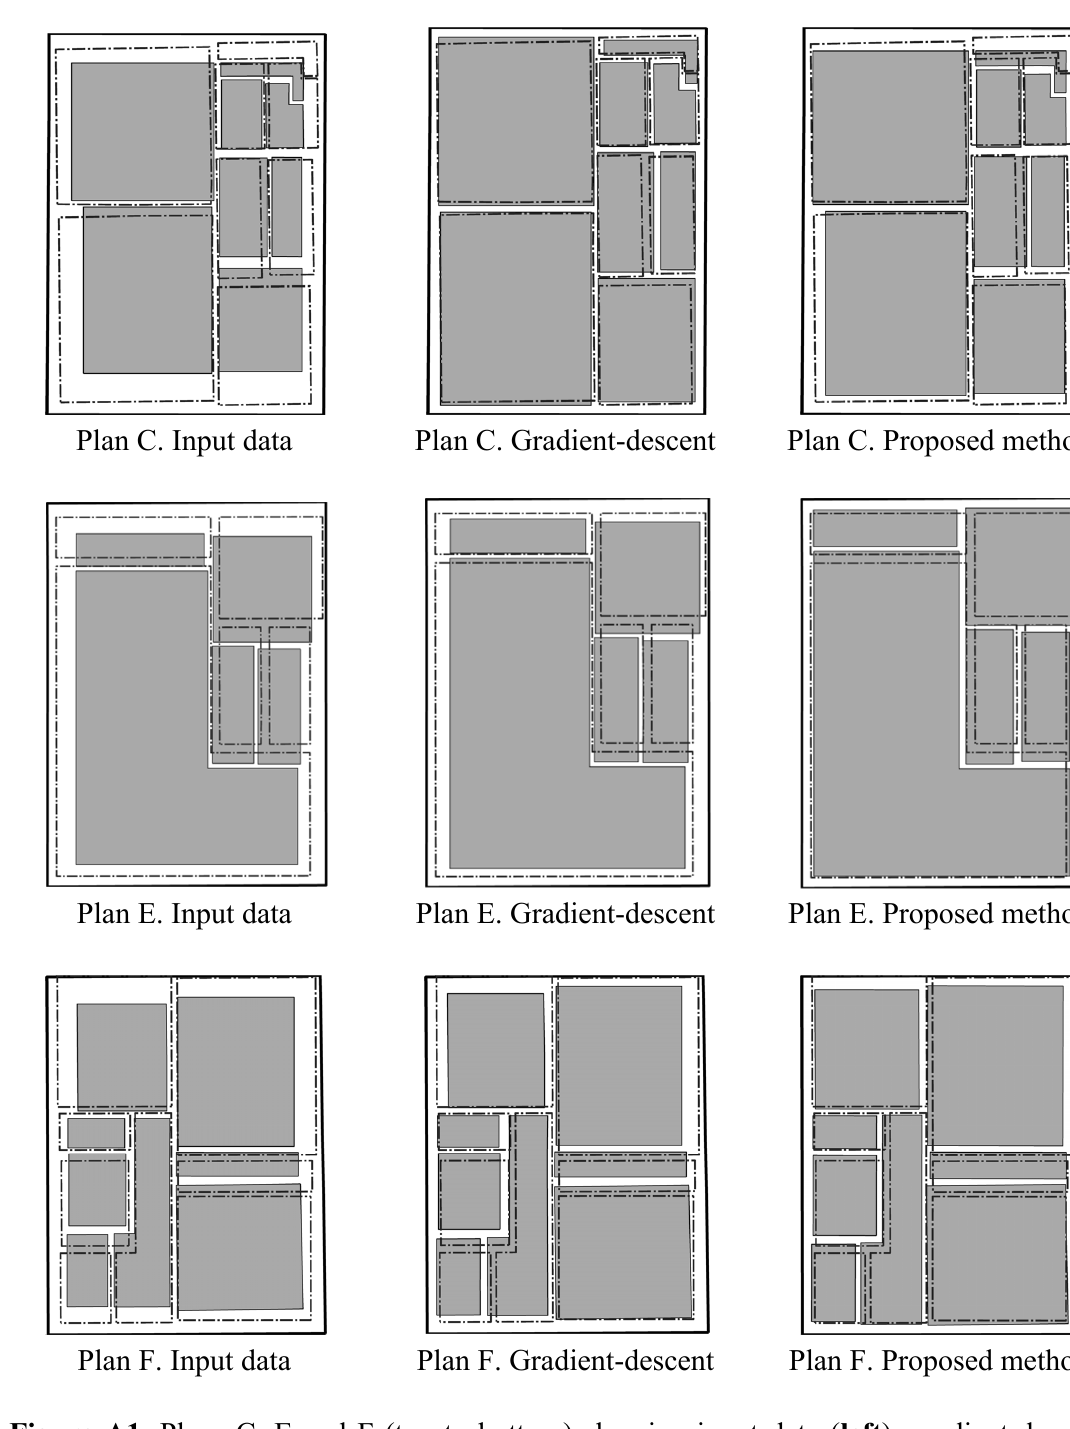
Figure A1. Plans C, E and F (top to bottom) showing input data ( left ), gradient-descent ( centre ) and proposed method ( right ) results. Plan measurements (solid grey), ground-truth (dashed